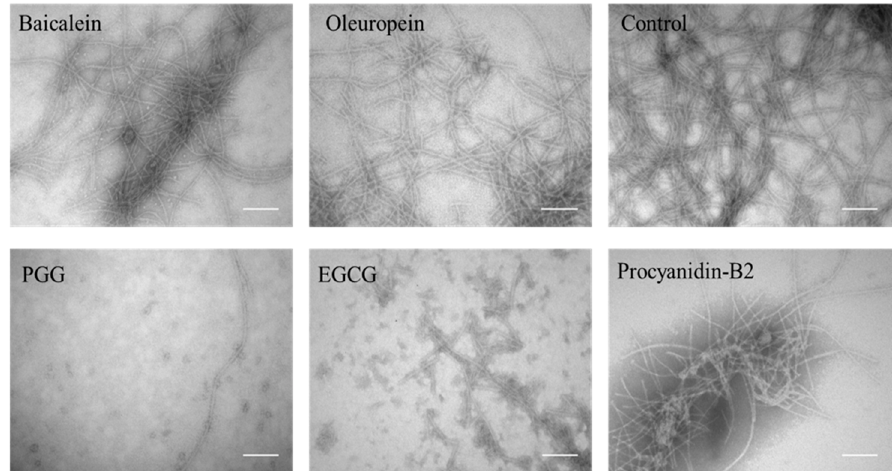
Figure 2. TEM image of aggregates after incubation with polyphenols. Scale bars are 200 nm.